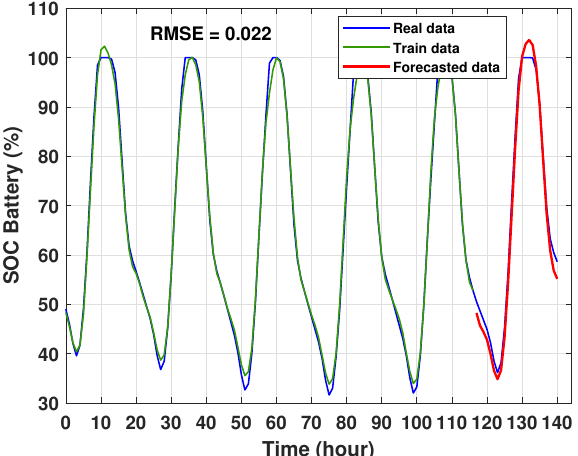
Figure 26. Hourly SOC battery forecasting.